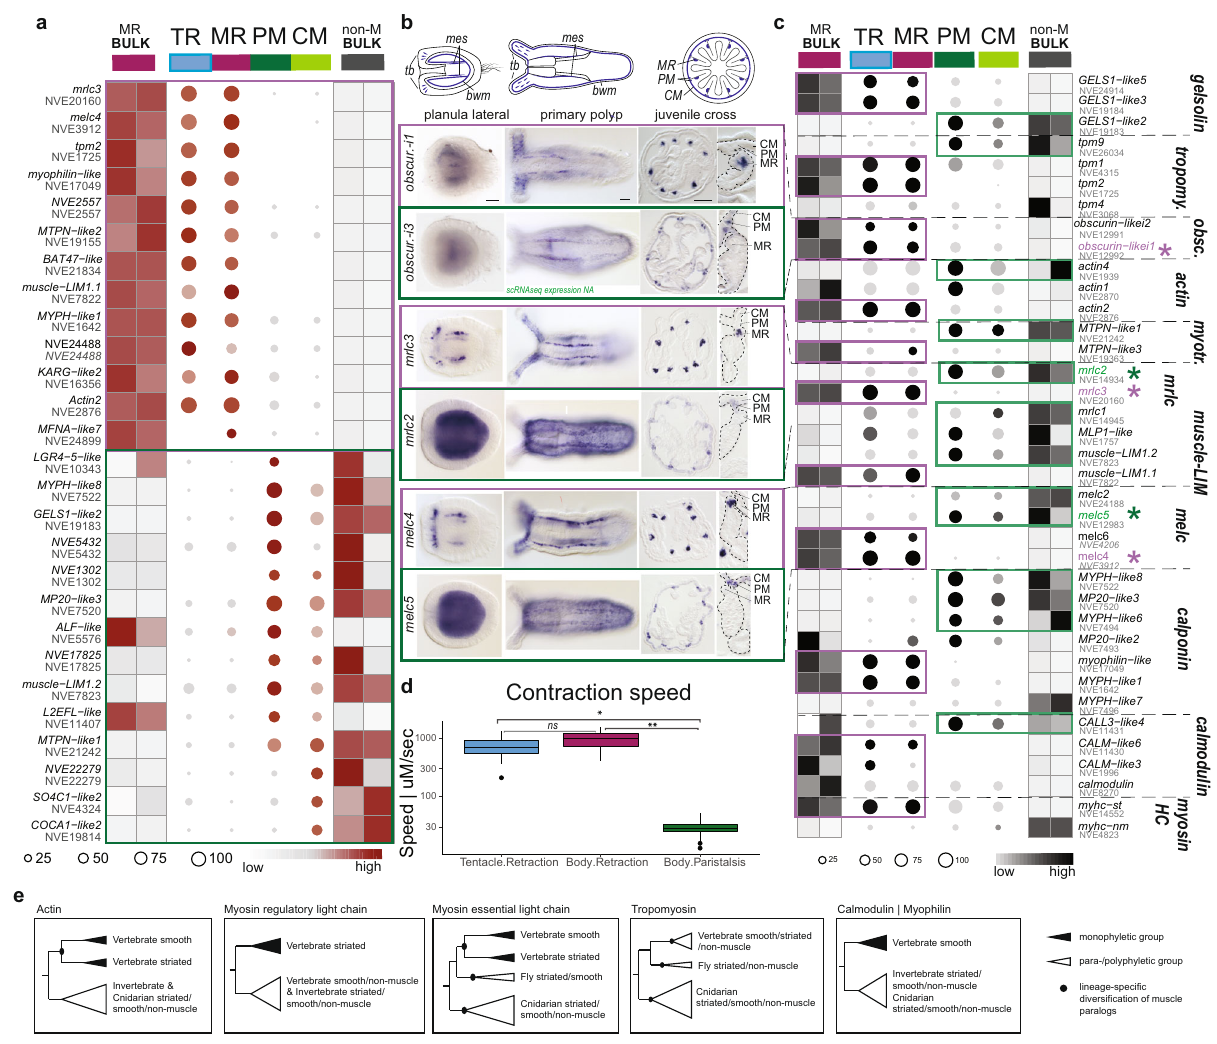
Fig. 2 | Structural protein gene expression reveals two functional classes of muscle cells. a Dot plot showing expression pro fi les for the 10 most signi fi cant differentiallyexpressedgenesforeachmusclecluster.Clusteridentityisindicated by the same coloration shown in (Fig. 1b, e). The relative expression pro fi le of the same gene set within the bulk dataset of the non-muscle cells (non-M BULK) and the muscle cells (MR BULK) are illustrated as square blocks. Common gene sets thatunitetheretractormuscle(TRandMR)andthebodywallmusculature(PRand CM) are boxed in purple and green, respectively. CM: circular muscle; MR: mesentery retractor; PM: parietal muscle; tentacle retractor: TR. b Validation of paralogous muscle gene sets by in situ hybridization. Schematic (top) and in situ hybridization for genes speci fi c to the retractor muscles (purple boxes) or body- wall muscles (green boxes) are shown. One labeled mesentery is shown for each gene, and scRNA expression pro fi les are indicated in ( c ). bwm : bodywall muscle (PM & CM); mes : mesenteries; tb : tentacle buds. The oral pole is to the left in all whole mount images. Scale bars are 50 µ m. c Expression pro fi le of paralogous